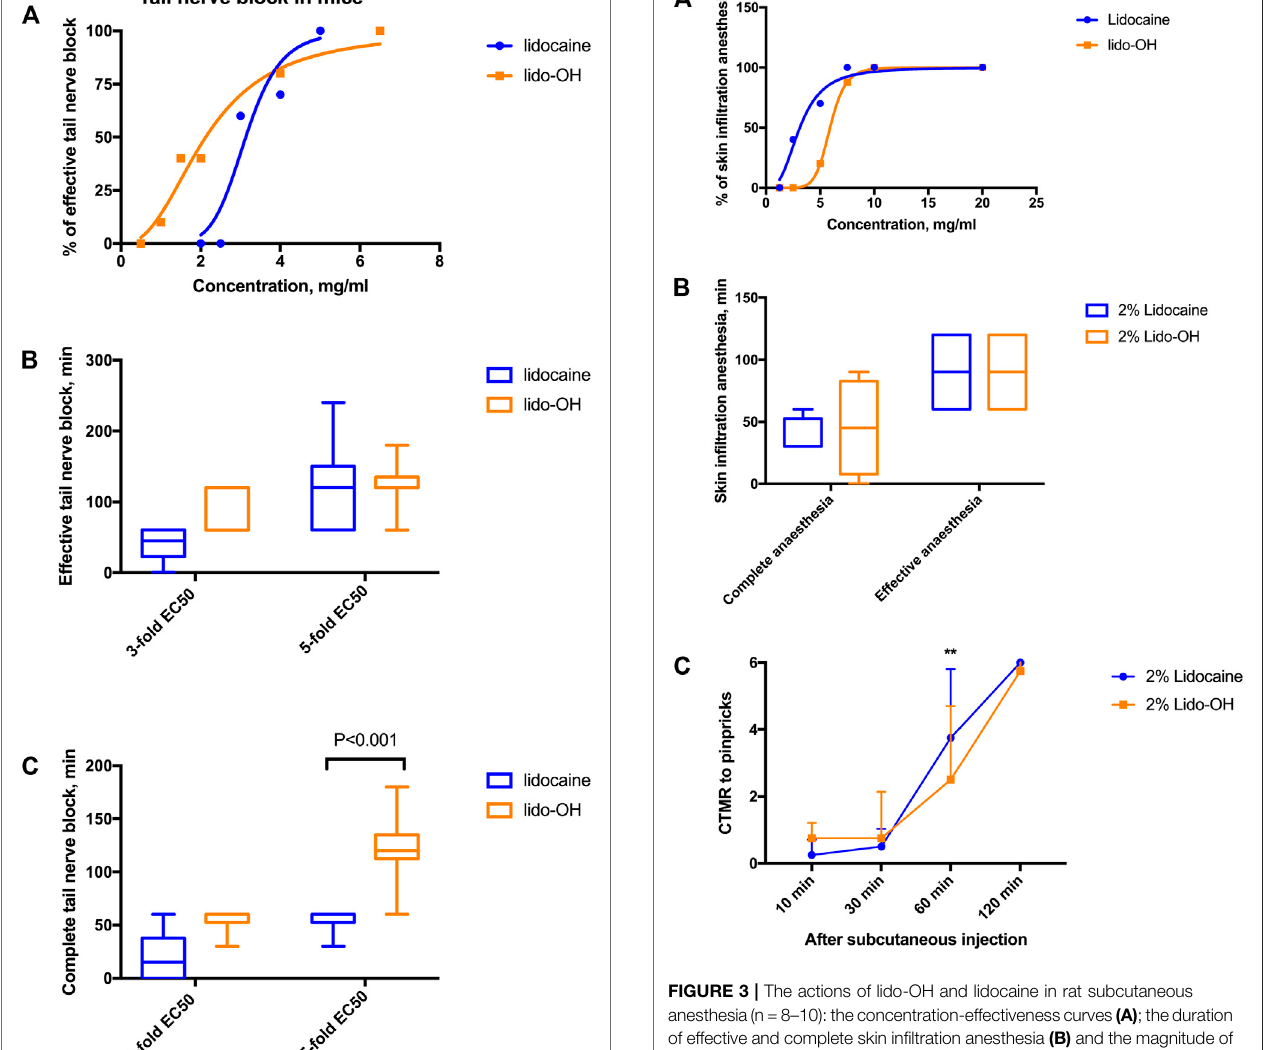
tail nerve block, 80 ± 31min vs. 40 ± 24min, p (cid:1) 0.18, for complete